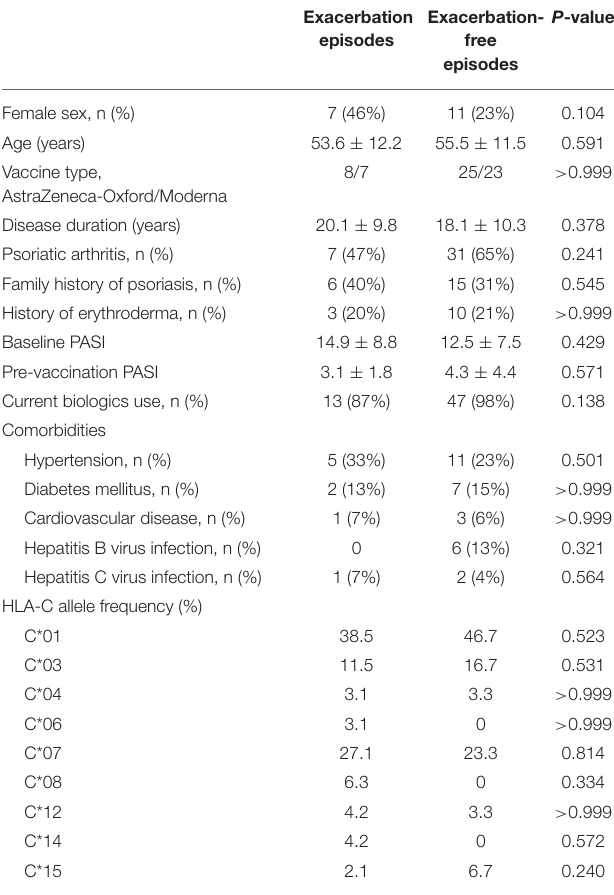
TABLE 2 | Comparison between the exacerbation episodes and the exacerbation-free episodes in patients who received COVID-19 vaccines.